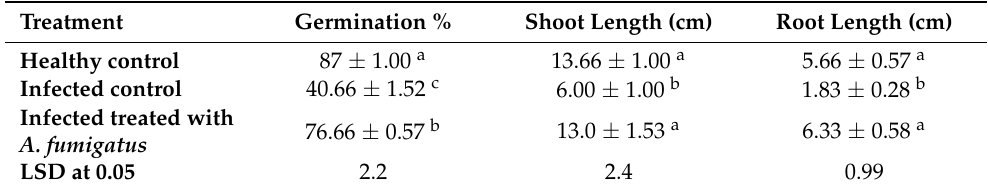
Table 3. Effect of A. flavus infection and A. fumigatus on germination % and shoot and root lengths in corn seeds.